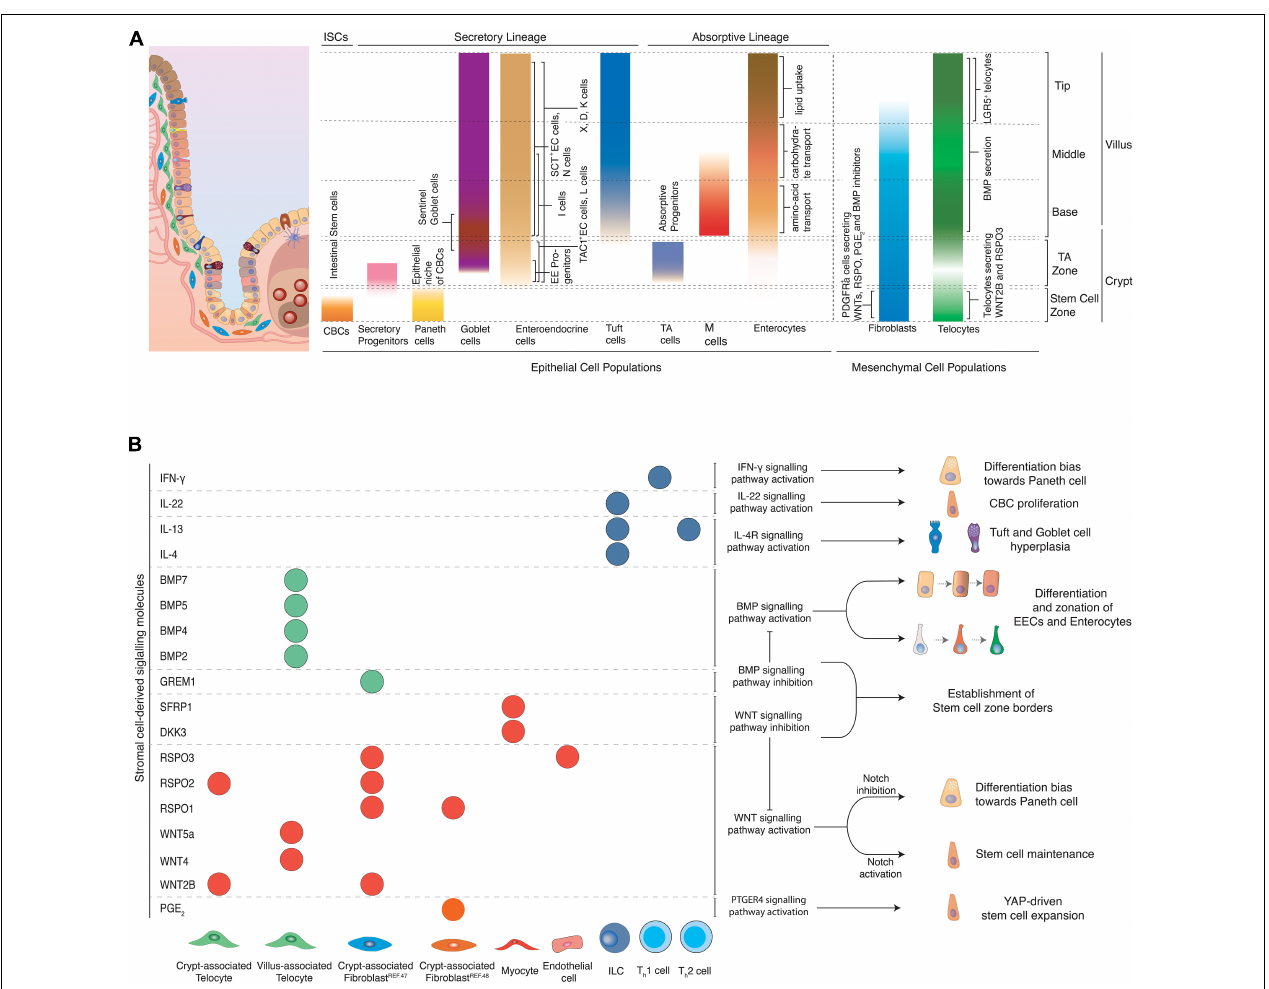
FIGURE 2 | (A) Topology of epithelial and mesenchymal cell populations across the crypt-villus axis. Distinct populations of epithelial and mesenchymal cells can be encountered at specific positions along the crypt villus axis. CBCs located at the crypt bottom, proliferate and can give rise to all epithelial cell types of the intestine. Secretory populations exist at various positions across the crypt-villus axis, including Paneth cells (crypt bottom) that protect and nurture CBCs, Tuft (villus) and goblet (crypt + villus) cells that coordinate inflammatory responses, as well as hormone-producing enteroendocrine cells (crypt + villus). Absorptive progenitors give rise to enterocytes and M cells. Enterocytes located at different parts of the villus are linked to distinct functions such as amino-acid (aa) and carbohydrate transport and lipid uptake. M cells are mainly located above Peyer’s patches and their main role is to transport antigens to the antigen-presenting cells underneath them for further processing. Stromal cells provide structural support to the tissue and provide epithelial cells with signaling molecules, regulating important processes such as proliferation and differentiation. Several fibroblast populations located at the crypt bottom in close proximity to the stem cell zone have been linked to production of WNTs and RSPO, which are essential for stem cell maintenance. Telocytes have varying secretory profiles depending on their position along the crypt-villus axis. A subset of telocytes found under the crypt produce canonical WNT ligands and RSPO3. However, telocytes locally concentrated at the villus base and tips and are linked to production of BMP ligands that promote differentiation of epithelial cells. (B) Effects of stromal cell-derived signals on intestinal epithelial cells. Stromal cells produce various signaling molecules affecting the behavior of intestinal epithelial cells. Telocytes and fibroblasts located near the stem cell zone secrete WNT ligands and RSPO to maintain stemness of CBCs, while WNT antagonists and BMP inhibitors, produced by myocytes and crypt-associated telocytes establish the limits that distinguish the stem cell zone from the rest of the crypt. Upon damage, fibroblast-derived PGE 2 drives the regeneration of stem cells via the YAP signaling axis. BMPs produced mainly by telocytes found in the villus induce differentiation and zonation of enterocytes, enteroendocrine cells and potentially other cell types as they migrate from the villus base toward the tip. Likewise, inflammatory signals derived from immune cells drive stem cell expansion and proliferation, instruct cell